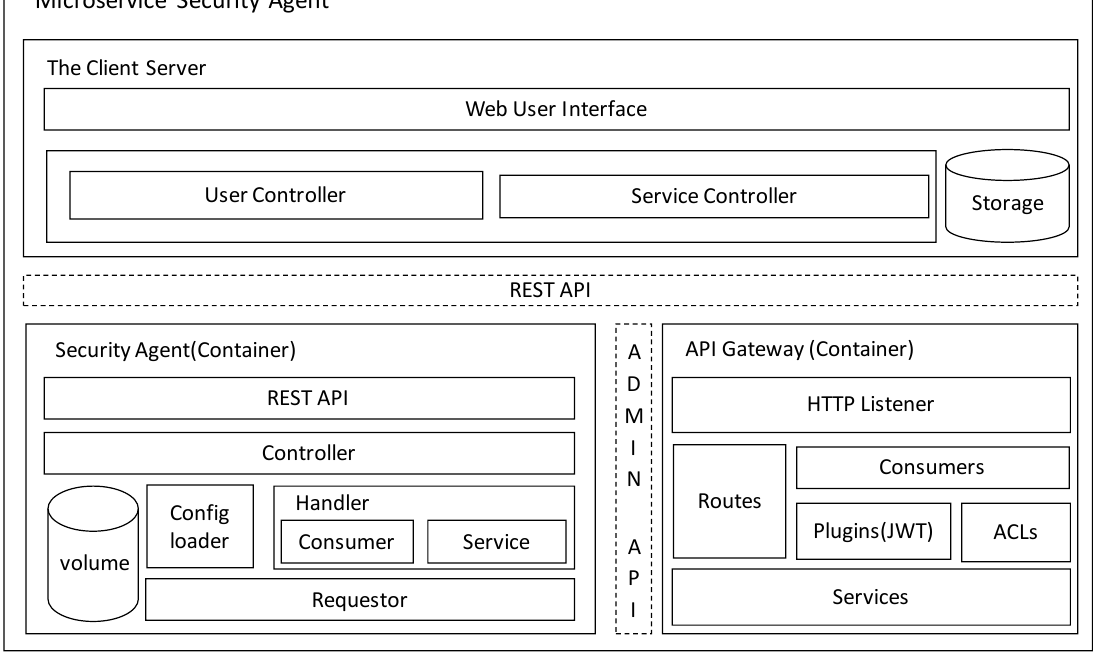
Figure 2. Configuration of the API gateway for microservice